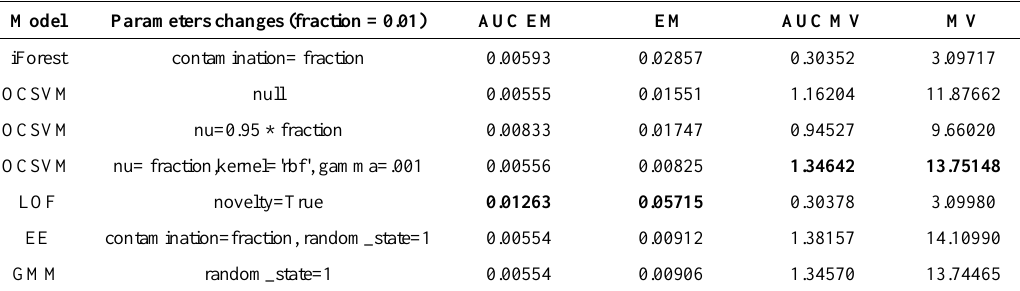
Table 2. Results for the novelty detection setting with PCA, where